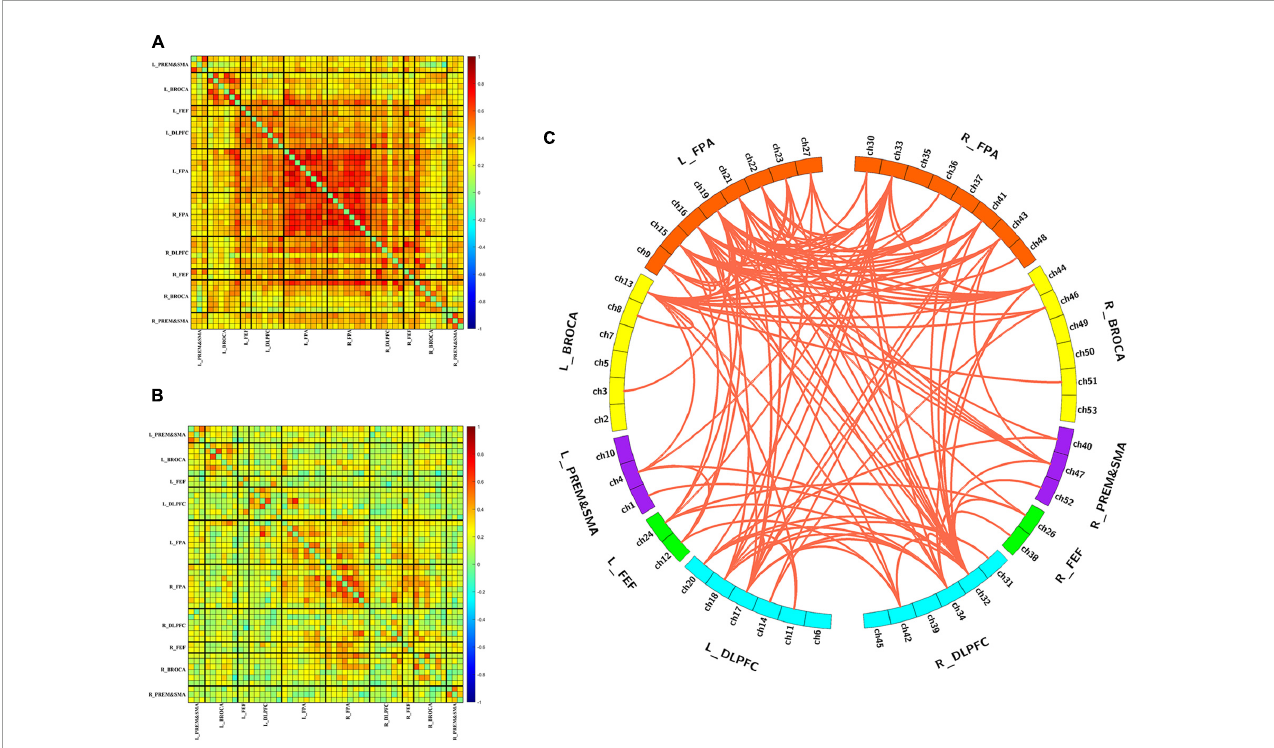
FIGURE2 Differences in functional connectivity between HC and MCS groups. (A) Group-averaged functional connectivity metrics in HC; (B) group-averaged functional connectivity metrics in MCS; (C) 118 functional connectivity that changed significantly between-group differences. L, left; R, right; PreM and SMA, premotor and supplementary motor area; BROCA, Broca’s area; FEF, frontal eye fields; DLPFC, dorsolateral prefrontal cortex; FPA, frontopolar